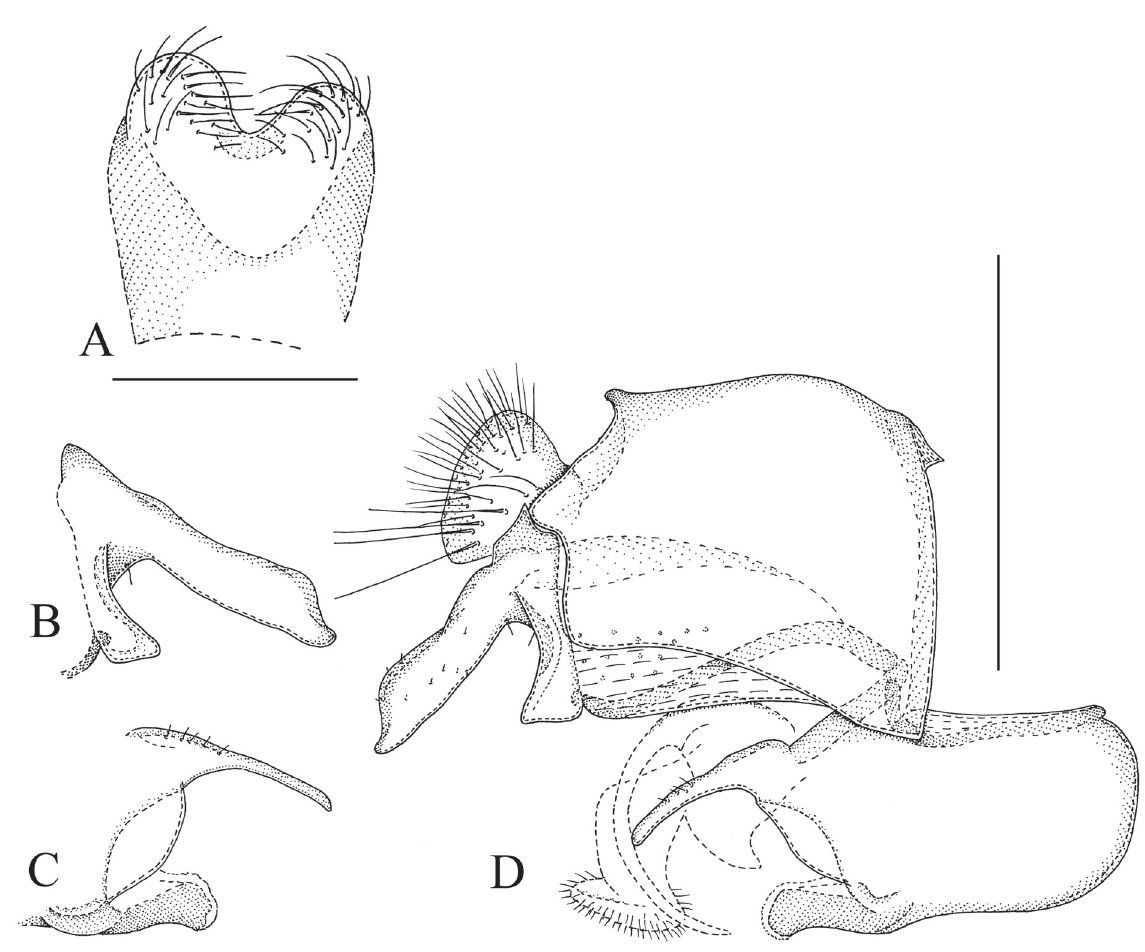
Fig. 66. Sphegina (Asiosph egina) orientalis Kertész, 1914, ♂ Vietnam. A . Sternum IV, ventral view. B . Left surstylus, lateral view. C . Left superior lobe with associated parts, lateral view. D . Genitalia, right side, lateral view. Scale bars = 0.5